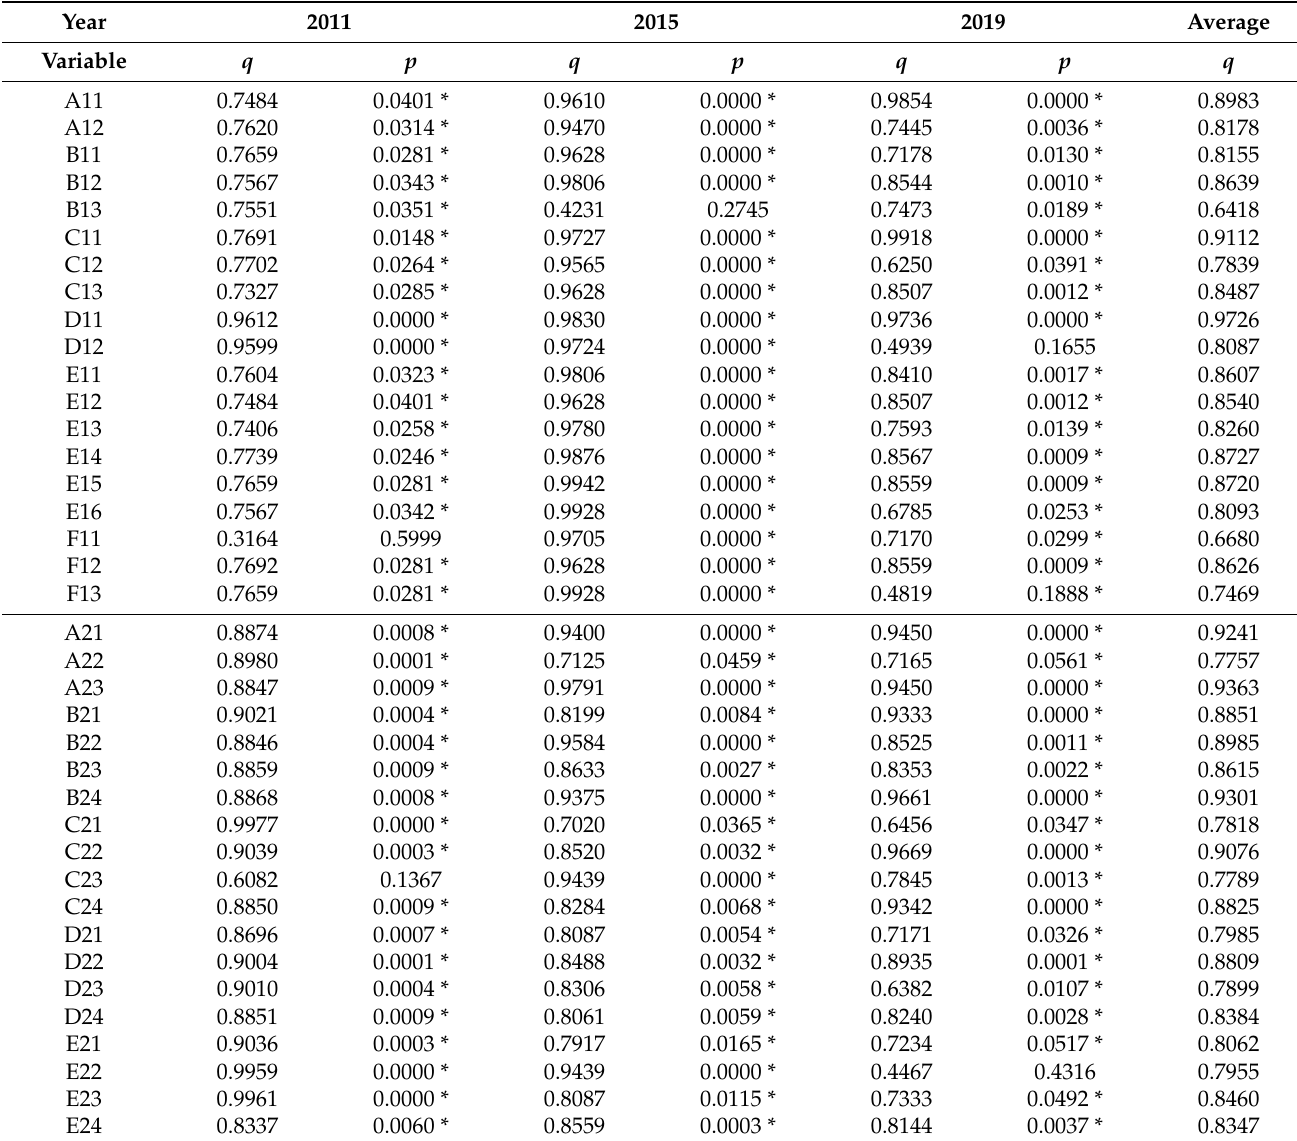
Table 9. Factor detection of symbiosis between tourism’s carbon emission efficiency (TCEE) and the tourism economy’s high-quality development